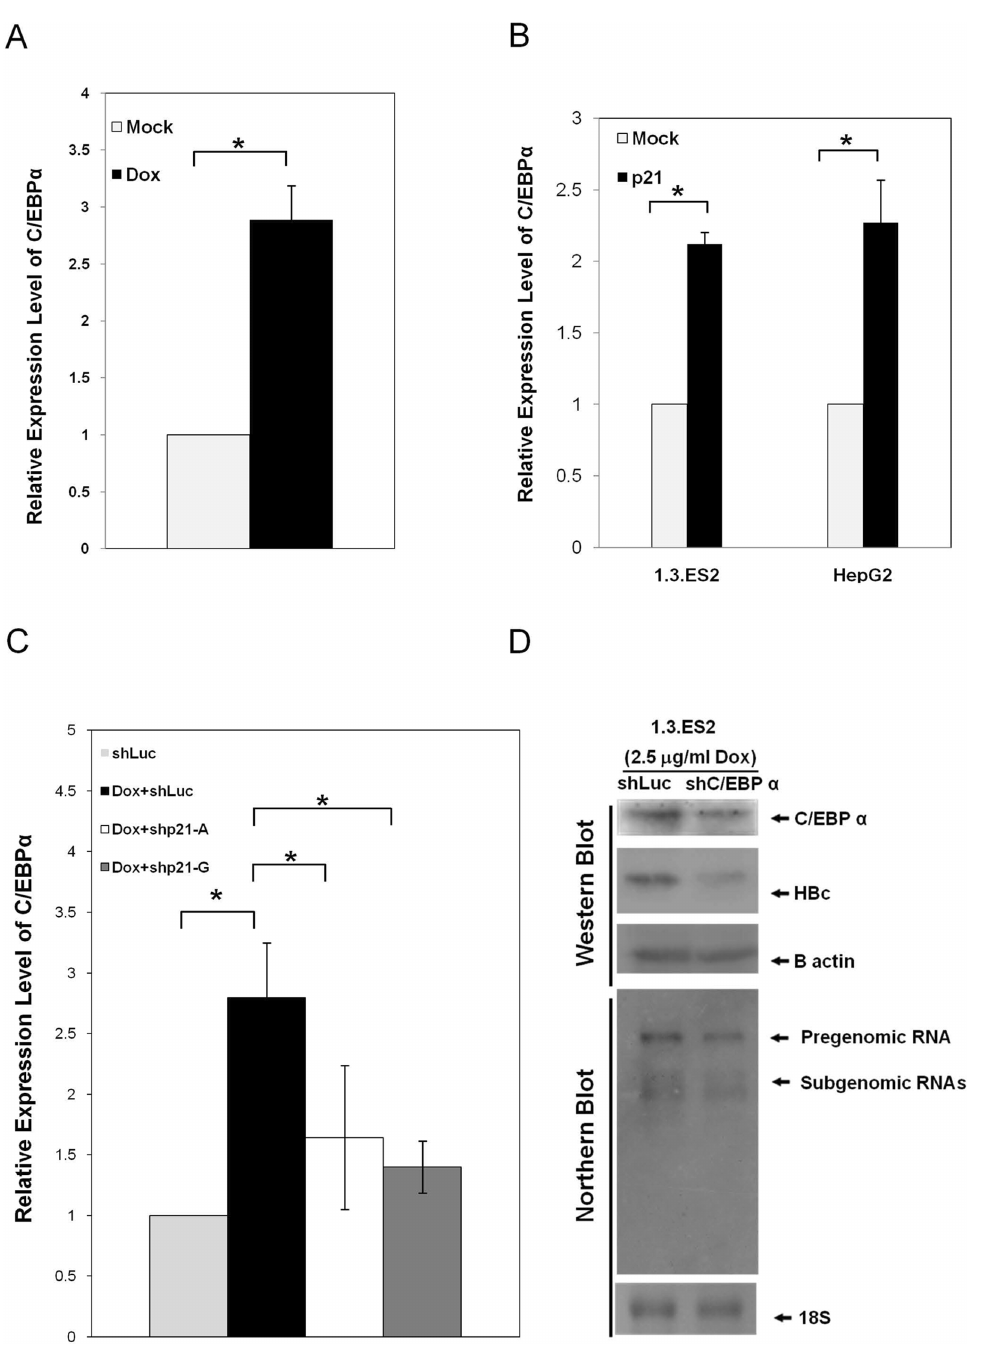
Fig 4. The elevation of C/EBP α by doxorubicin and its impact on activation of HBV replication. (A) The elevation of C/EBP α by doxorubicin. 1.3.ES2 was treated with doxorubicin for 1 hour and then the culture medium was replaced with fresh culture medium for three days. Next, total RNA was harvested in order to carry out quantitative RT-PCR. (B) The elevation of C/EBP α by p21 over-expression. 1.3.ES2 cells or HepG2 cells over-expressing p21 were harvested for analysis of the expression level of C/EBP α by quantitative RT-PCR. (C) The role of p21 in doxorubicin-mediated C/EBP α elevation. 1.3.ES2 cells were infected with lentivirus expressing p21 shRNA. Twenty-four hours post-infection, cells were treated with doxorubicin for 1 hour, which was followed by replacing the culture medium with fresh culture medium. Culturing was then continued for 3 days. Next, total RNA was harvested for analysis of the expression level of C/EBP α by quantitative RT-PCR. The expression level of B2M was used as a reference control. (D) 1.3.ES2 cells were infected with lentivirus expressing C/EBP α shRNA for 24 hours, treated with doxorubicin for 1 hour, and this was followed by culturing in fresh culture medium for 3 days. The expression levels of HBV transcripts, HBcAg and C/EBP α were analyzed by Northern blot and Western blot.analysis, * , P < 0.01, 2-sided unpaired t